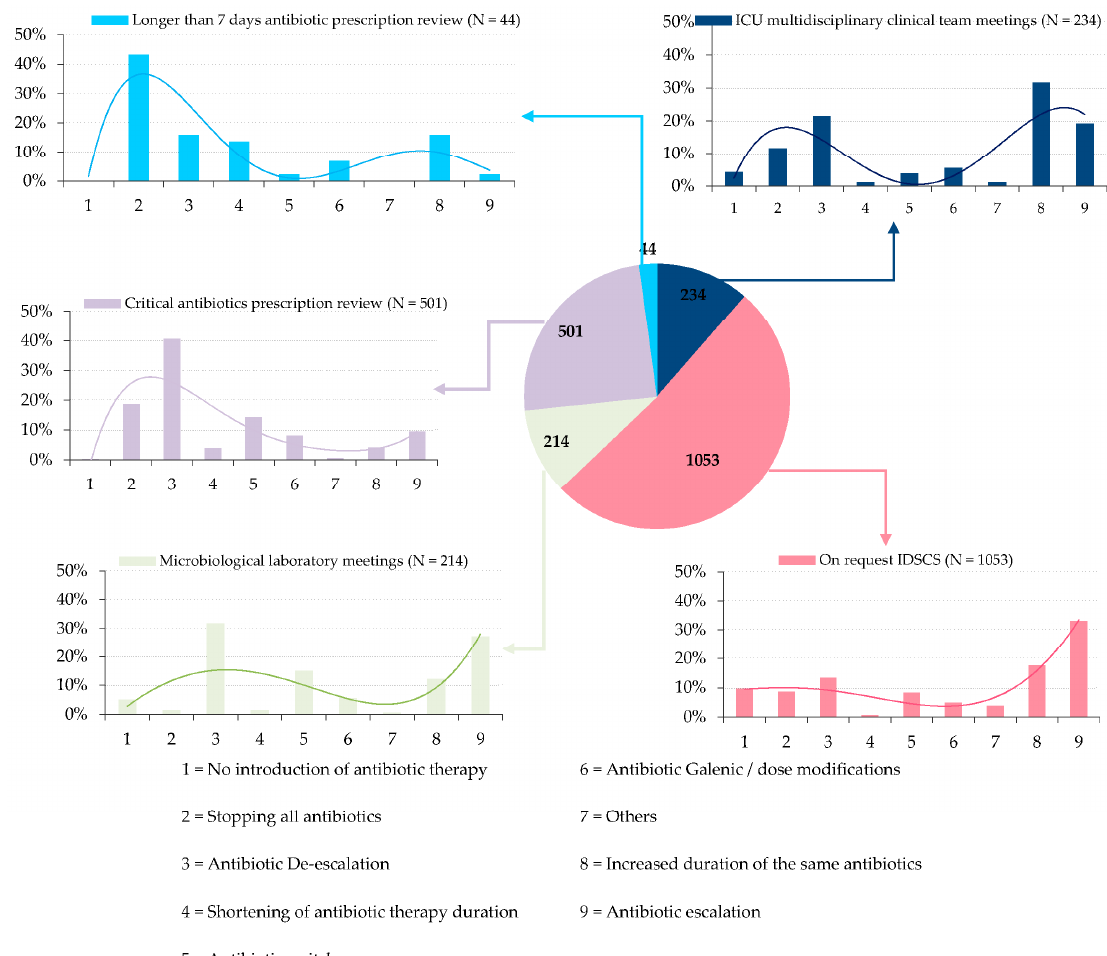
Figure 4. Advice type according to di ff erent kind of interventions. Distribution of the 2046 interventions noted in the electronic patient record related to 1430 hospital stays and rate of propositions according to di ff erent kind of interventions. N = number of interventions. IDSCS = infectious diseases specialist consulting service.